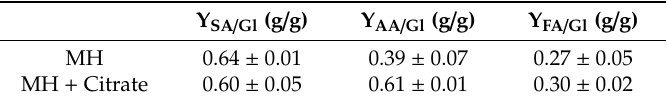
Table 2. Yields of succinic, acetic and formic acid obtained by growing A. succinogenes 130Z on MH medium (with glucose as carbon source) and on MH medium plus citrate.